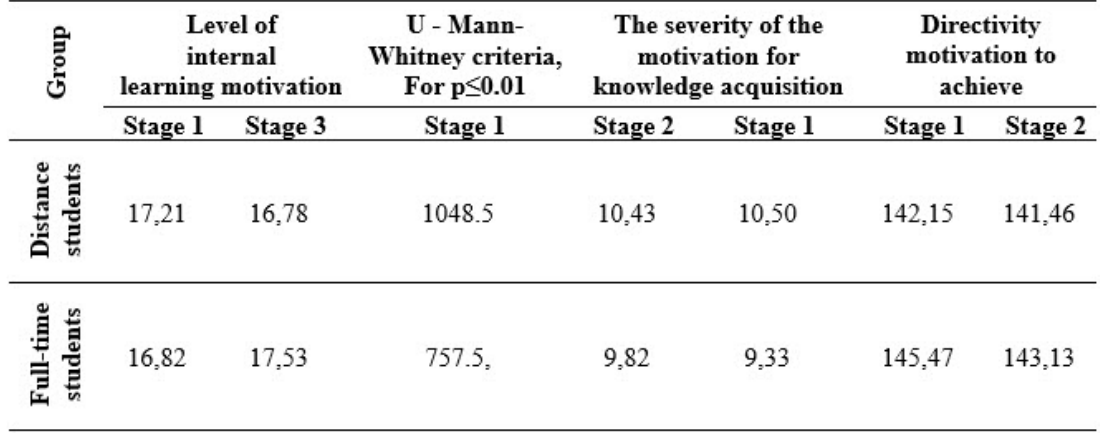
Table 1. Comparison the results of ascertaining and control experiment in the distance and full-time intellectually gifted students